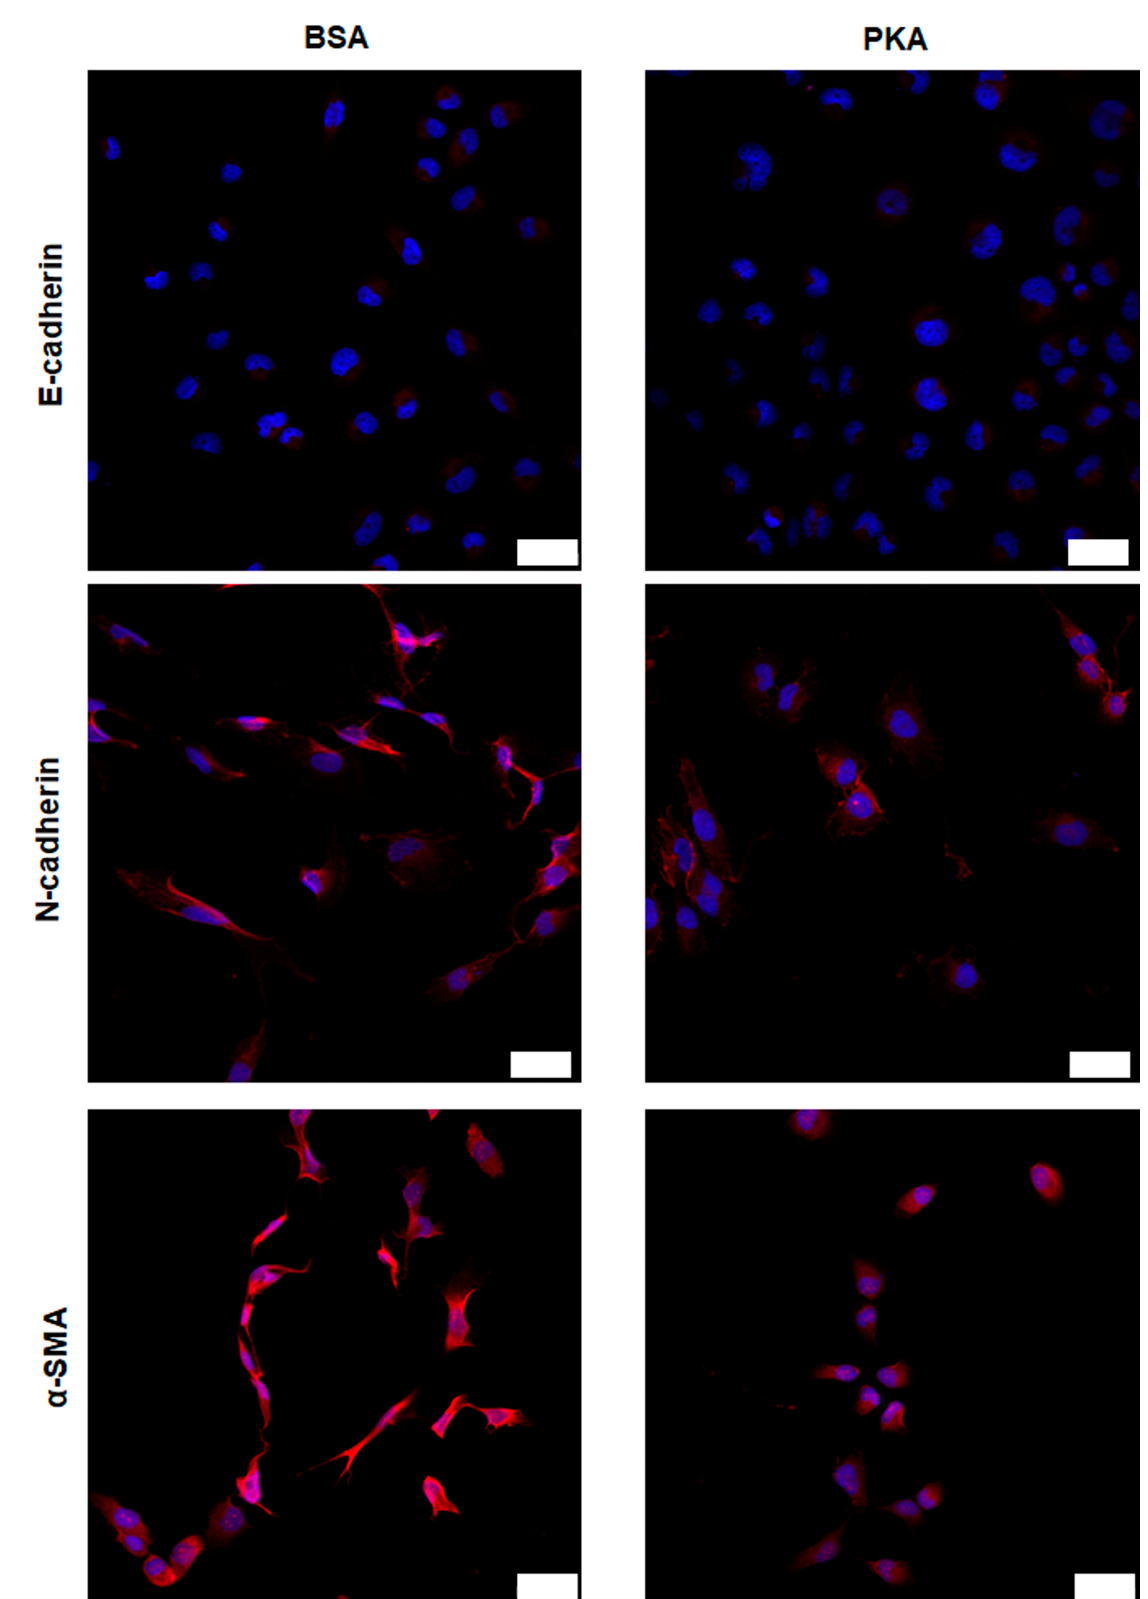
Figure 4. Expression analysis of E-cadherin, N-cadherin, and α -SMA after PKA delivery observed by CLSM. E-cadherin, N-cadherin, and α -SMA expression were examined by immunofluorescence analysis using confocal laser scanning microscopy 5 days after CRISPRMAX-based delivery, with the control (BSA) (left panel) vs. with PKA (right panel). Cell nuclei were visualized by DAPI. Confocal images were taken at 200x magnification (scale bars, 50 μ m).